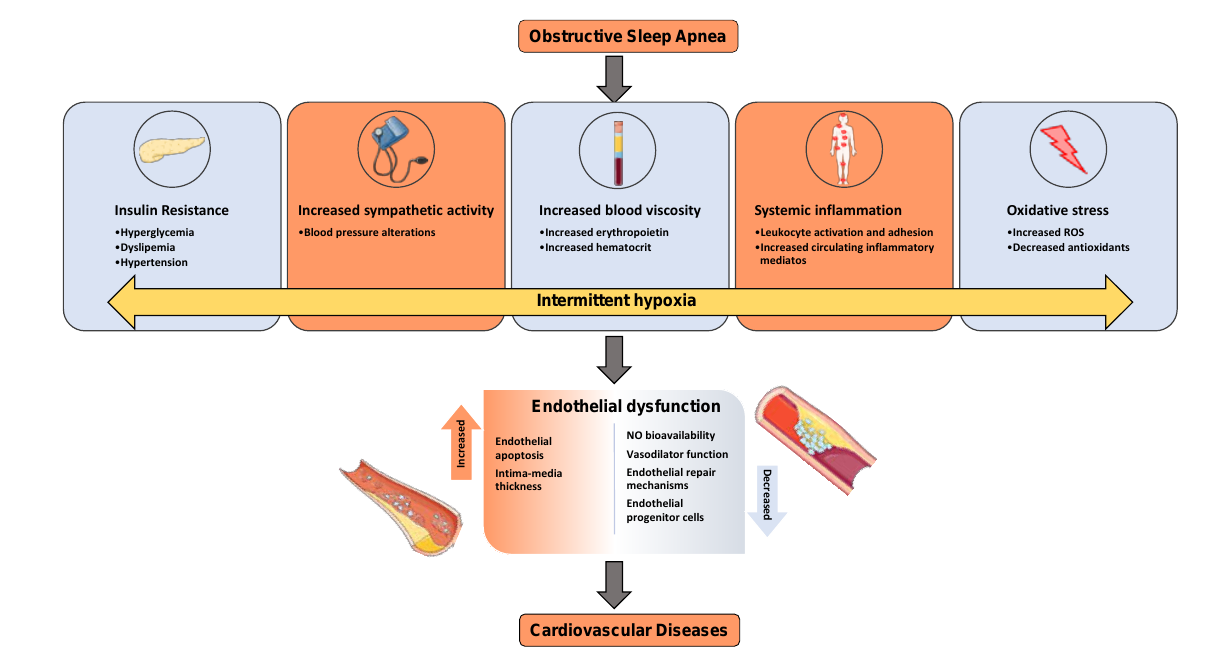
Figure 1. Diagram illustrates the effect of OSA and IH on endothelial dysfunction and cardiovascular diseases and associated mechanisms.